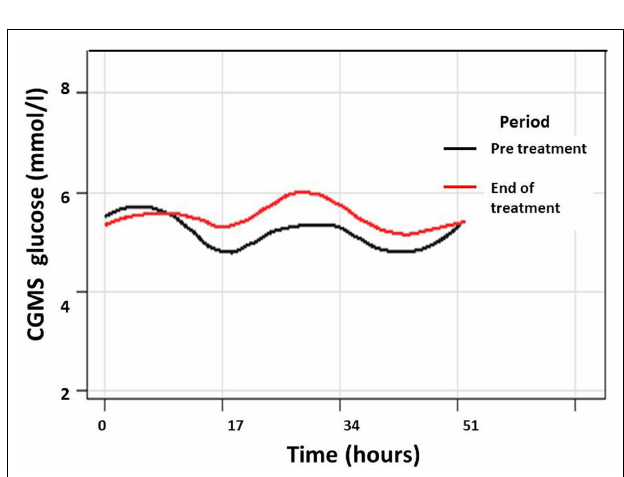
FIGURE 5 | Mean (95% confidence intervals) CGMS levels at pre-treatment, end of treatment, and follow-up time periods in patient #4, who carries a HADH mutation . Following treatment with PUFA, the patient’s CGMS glucose increased significantly, with reduction after treatment was